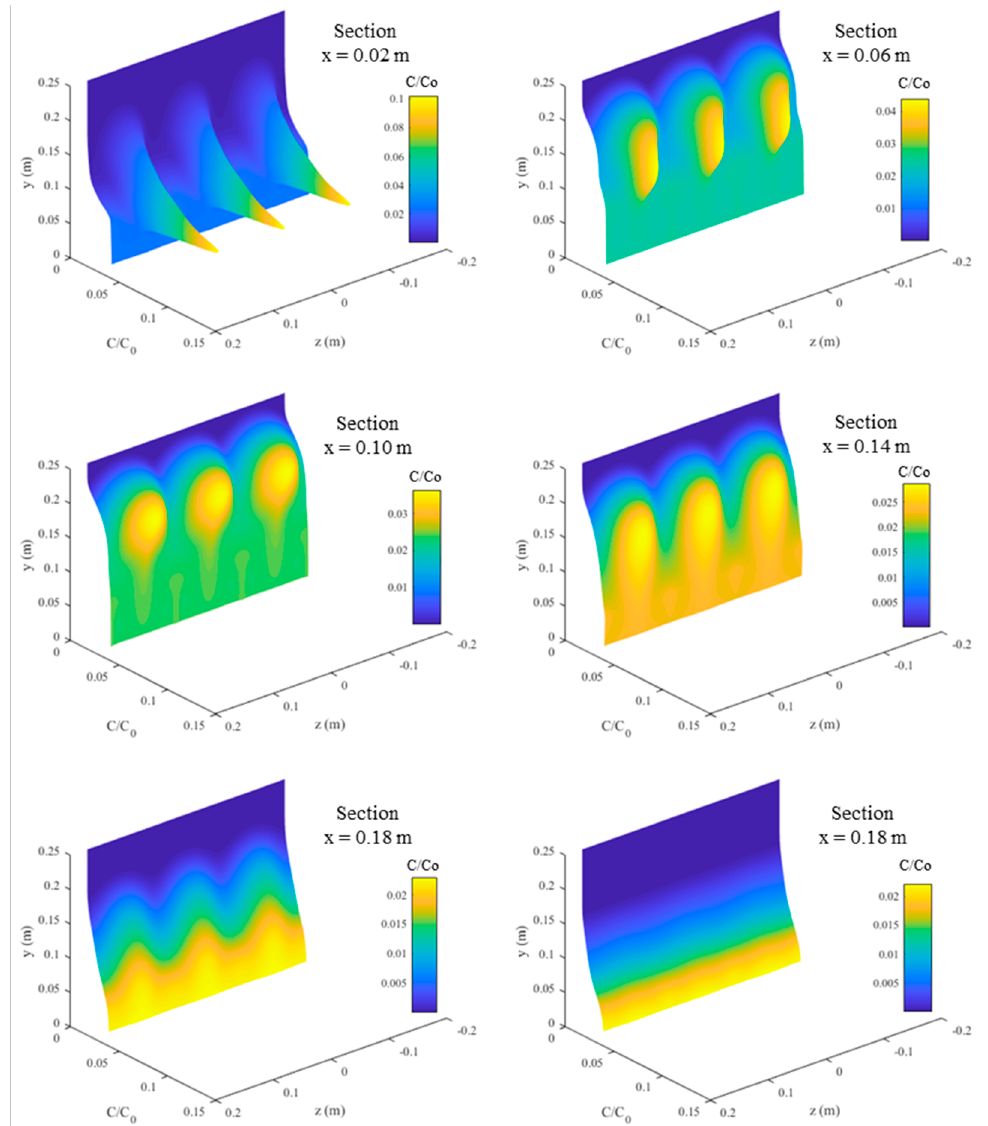
Figure 3. Concentration fields at various downstream locations; Case C1, F = 62.9, and s / ( d · F ) = 0.94.